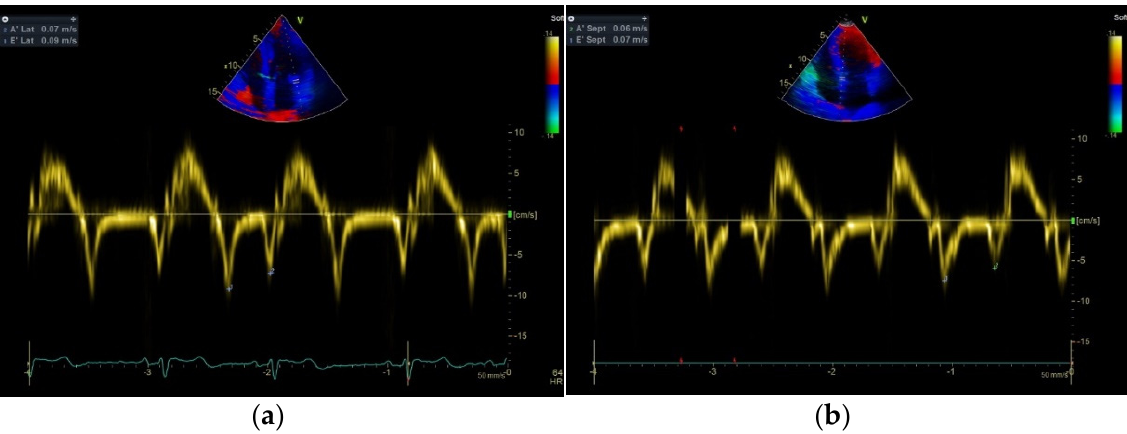
Figure 1. An example of tissue Doppler recordings of lateral ( a ) and septal ( b ) annular velocities from an athlete in group A .